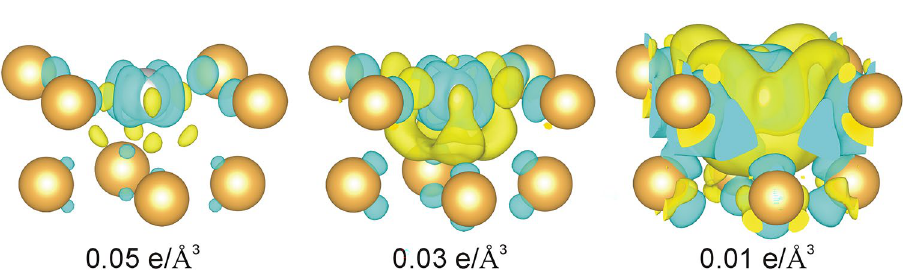
Figure 6. Isosurfaces of charge density difference for various levels. Yellow colour signifies accumulation and blue denotes depletion of